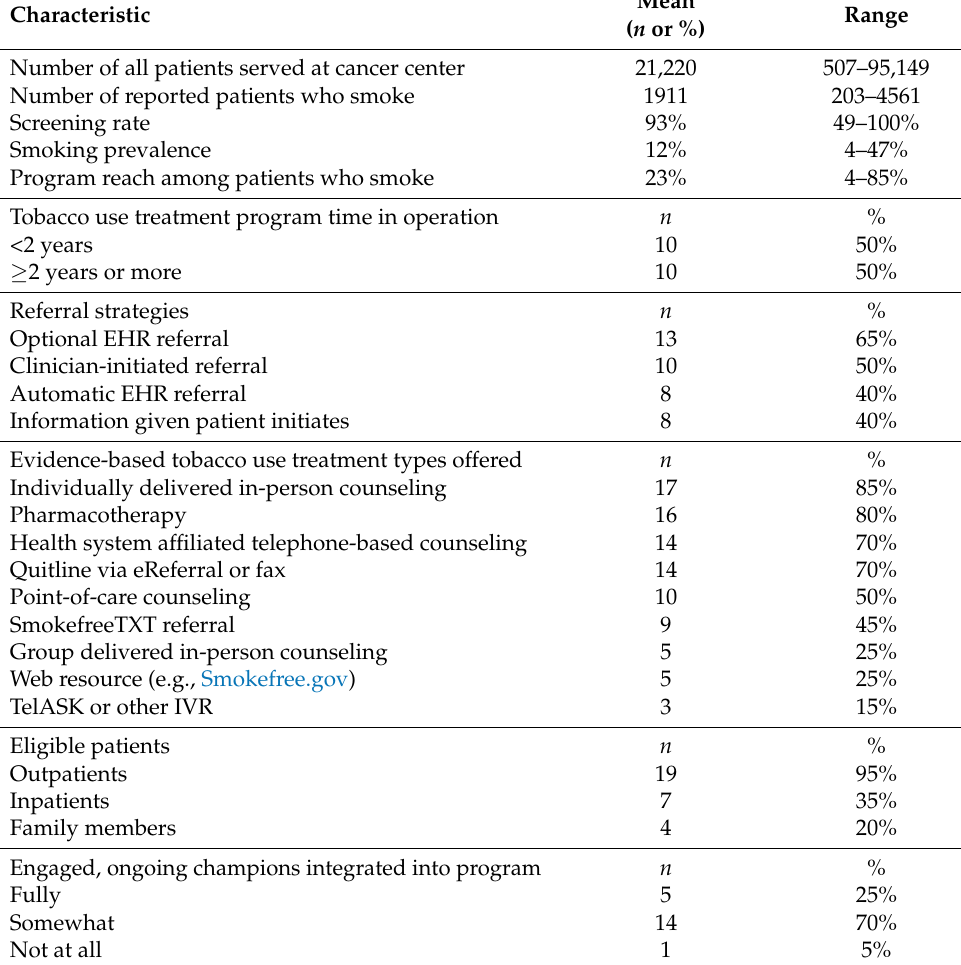
Table 2. Cancer center and tobacco dependence treatment program